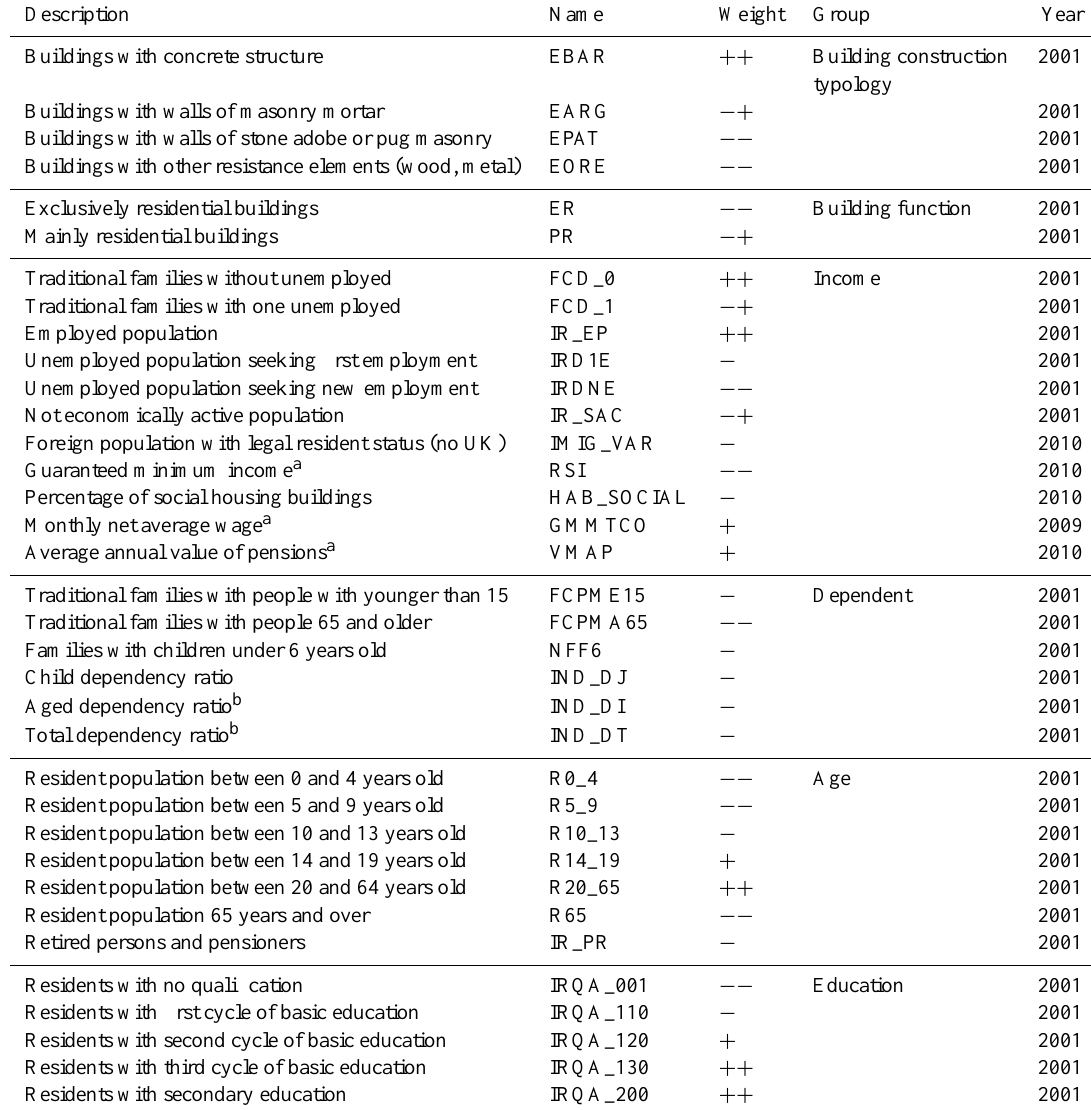
Table 1. Variables used in this study (with the exception of the percentage of urban area all data were obtained from Statistics